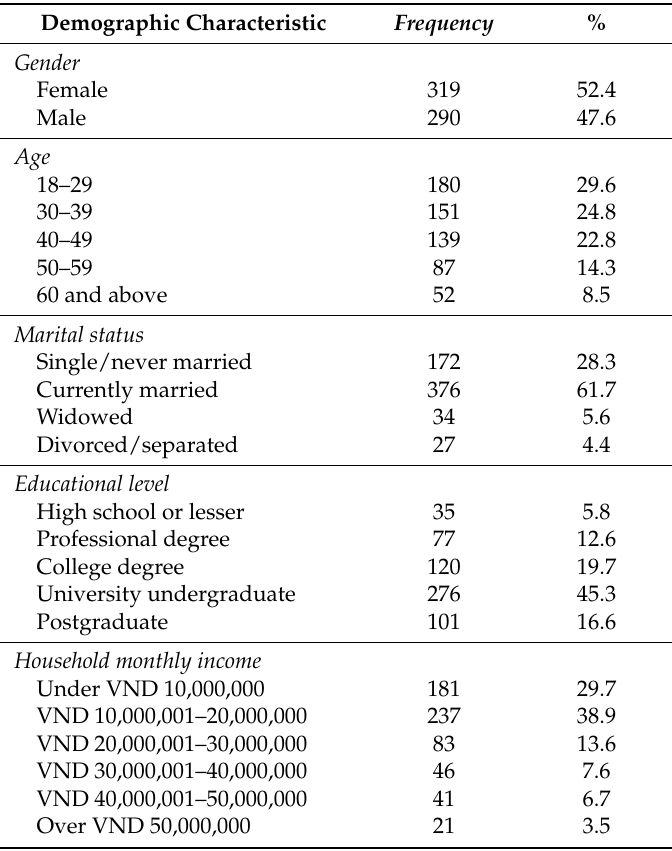
Table 1. Demographic profile of the